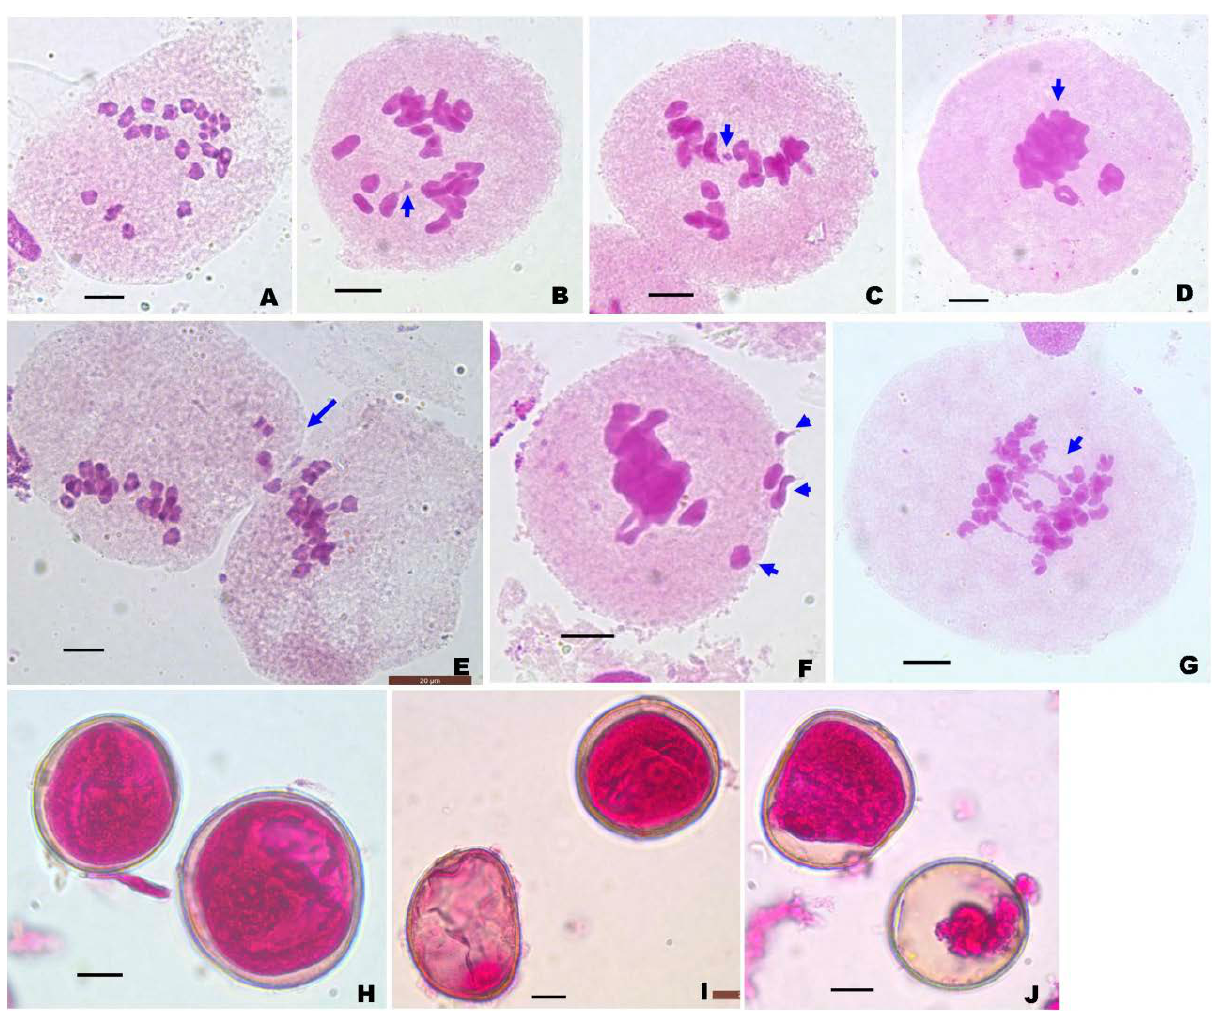
Figure 2. Male meiosis in Elymus nutans : (A) M-I PMC with equal-sized 21 bivalents; (B) M-I PMC with 1B-chromosome associated with A-bivalent (arrowed); (C) M-I PMC with independent 1B-chromosome (arrowed); (D) M-I PMC with chromatin stickiness; (E) M-I PMC depicting the phenomenon of cytomixis (arrowed); (F) M-I PMC with migrated chromatin material as pycnotic mass (arrowed); (G) A-I PMC with non-synchronous dysjunction of bivalents (arrowed); (H) heterogeneous sized pollen grains (arrowed); (I, J) fully stained fertile, partially stained and unstained as sterile pollen grains. Scale bar=10 μ